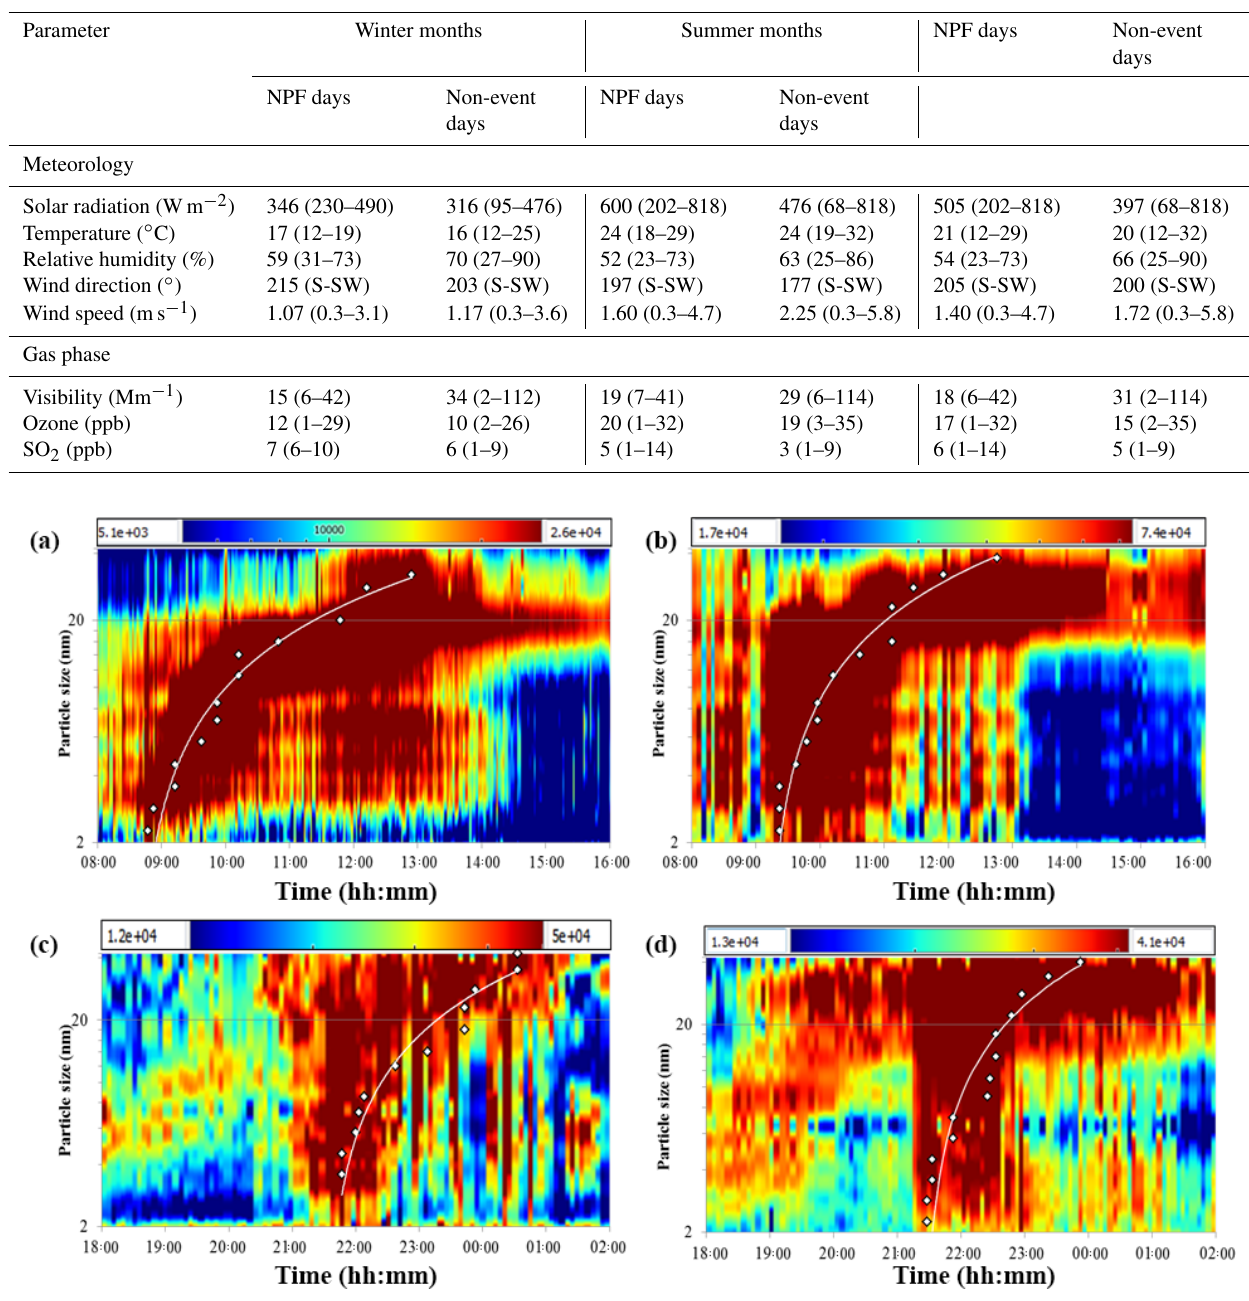
Figure 2. NAIS spectrograms of the day time NPF events (a,b) and night time NPF (c,d) . The colour contour represents the PNC and the markers represent the times at which the PNC reached its maximum value at each particle size. The unit of PNC is per cubic